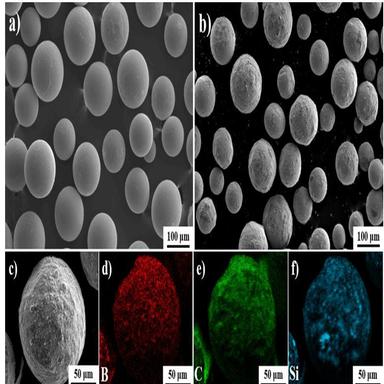
Morphologies of the powders before and after milling: (a) SEM-SE micrograph of the initial matrix powders, (b,c) SEM-SE micrograph of the milled powders, (d–f) EDS elemental mappings of B, C, Si across the (c).